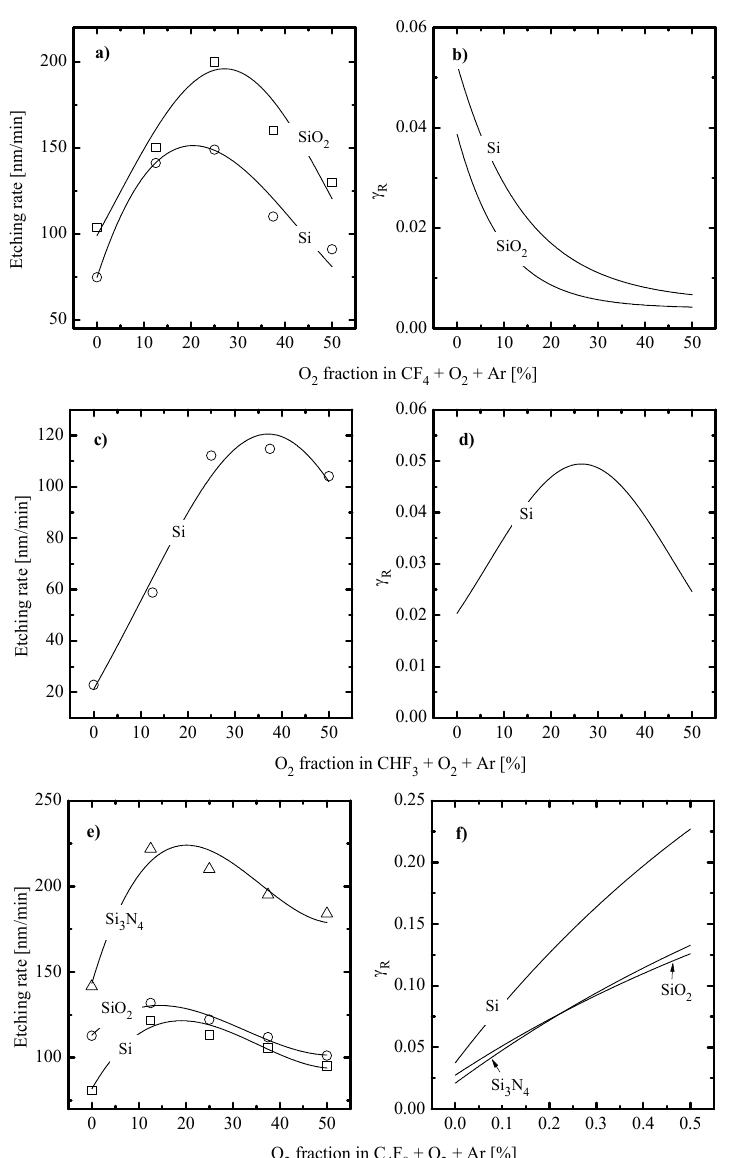
Figure 10. Etching rates ( a , c , e ) and effective reaction probabilities for F atoms ( b , d , f ) for various Si-based materials in oxygenated fluorocarbon plasmas. In ( a , b ): 50% CF 4 + O 2 + Ar plasma at p = 6 mTorr, W = 700 W and W dc = 200 W. In ( b , c ): 50% CHF 3 + O 2 + Ar plasma at p = 6 mTorr, W = 700 W and W dc = 200 W. In ( e , f ): 50% C 4 F 8 + O 2 + Ar plasma at p = 10 mTorr, W = 700 W and W dc = 200 W.